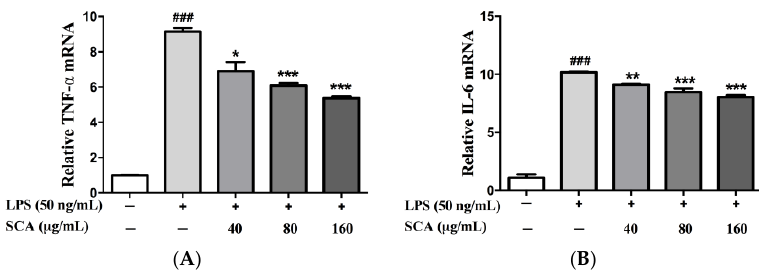
Figure 4. Effects of SCA on TNF-α ( A ) and IL-6 ( B ) mRNA expressions. RAW 264.7 macrophages were treated with SCA (40, 80 and 160 μg/mL) for 1 h and then stimulated with LPS (50 ng/mL) for 24 h. The TNF-α and IL-6 mRNA expressions were analyzed by real-time PCR. * p < 0.05, ** p < 0.01 and *** p < 0.001 versus LPS-only treatment group; ### p < 0.001 versus control group.